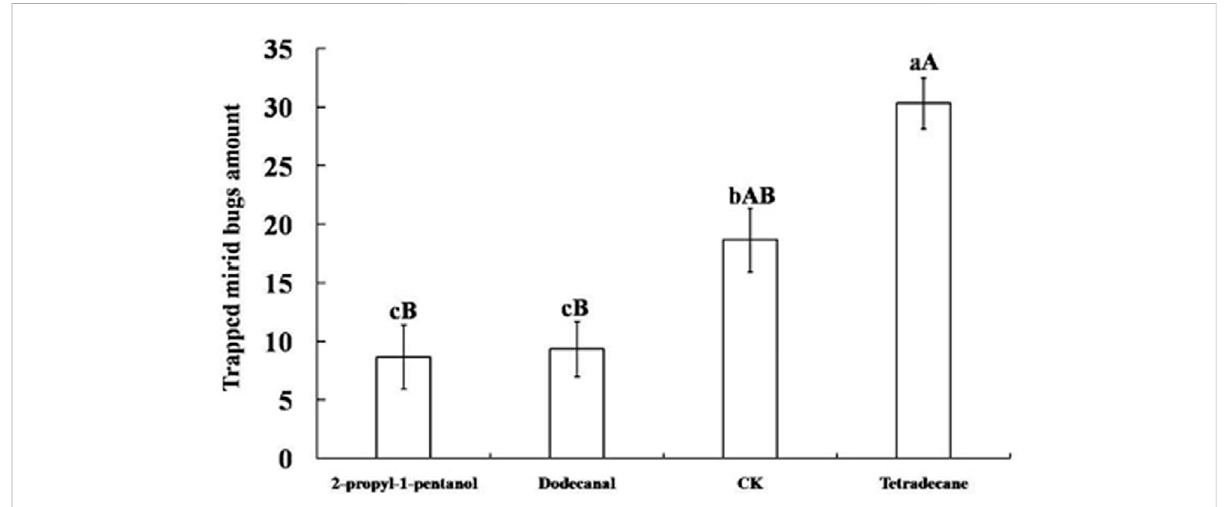
FIGURE 3 Mirid bugs trapped by yellow boards with different attractant. Different uppercase and lowercase letters indicated extremely signi fi cant ( p < 0.01) and signi fi cant ( p < 0.05) differences of mirid bugs amount that trapped by yellow boards with three different attractants and control group ( Least signi fi cant difference test ).